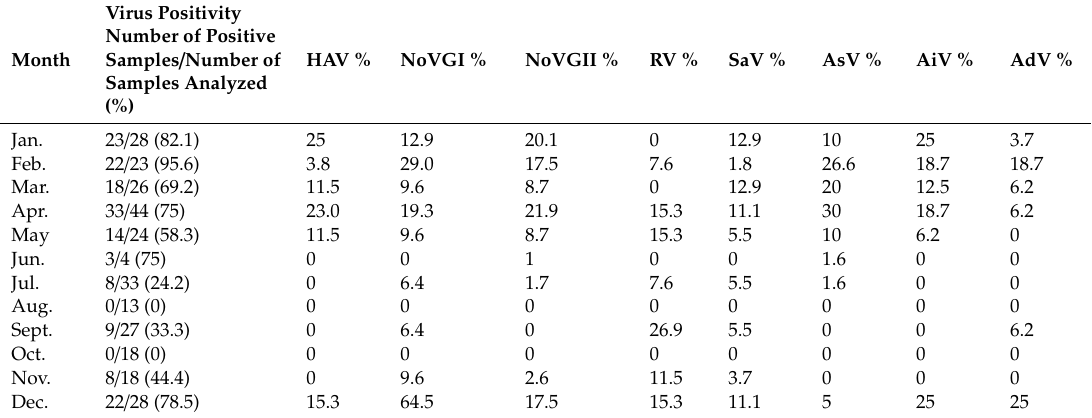
Table 6. Seasonal trend for virus positive samples from 2015 to 2017.